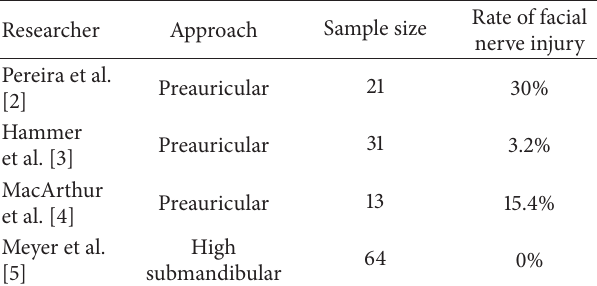
Table 1: Reported rate of facial nerve